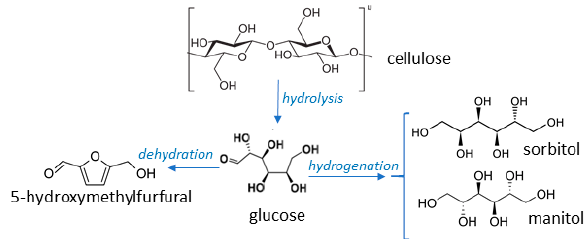
Figure 5. TEM images and Ru particle size distribution of catalysts: Ru/SA ( a ), ( d ) and ( g ); Ru/SASu ( b ), ( e ) and ( h ); and Ru/SAS ( c ), ( f ) and ( i ).